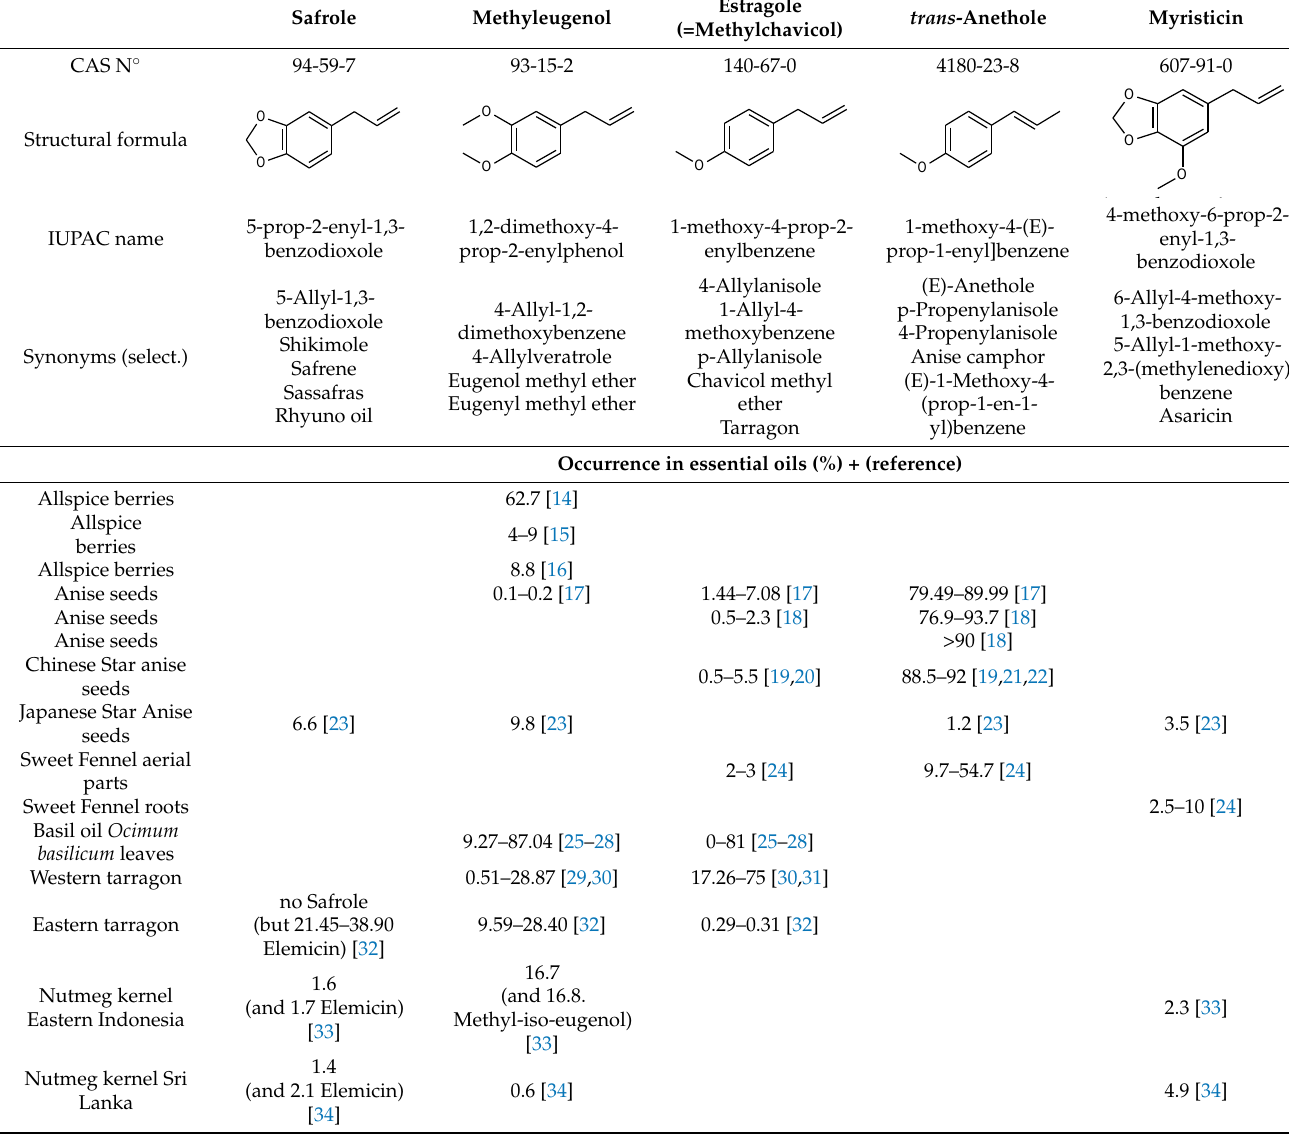
Table 1. Occurrence of safrole, methyleugenol, estragole, trans -anethole, and myristicin found in essential oils (EO) from herbs and spices.